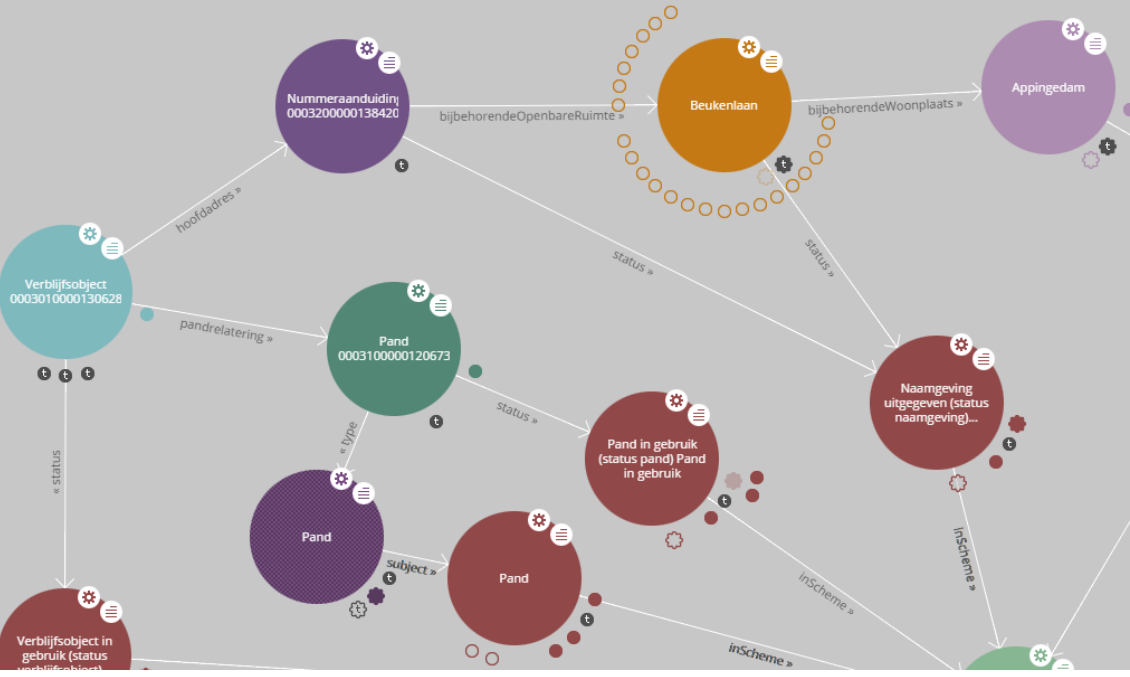
Figure 3. A view of the LodLive graph browser. Each node represents a resource. Edges between nodes denote properties that hold between